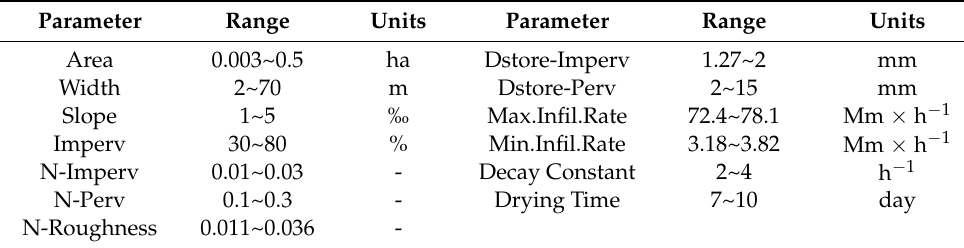
Figure 6. Generalized map (sub-catchments, nodes, links, etc.) of the Shuixianghuayuan old residen- tial area in SWMM model. Table 1. Ranges of hydrologic parameters for the stormwater management model